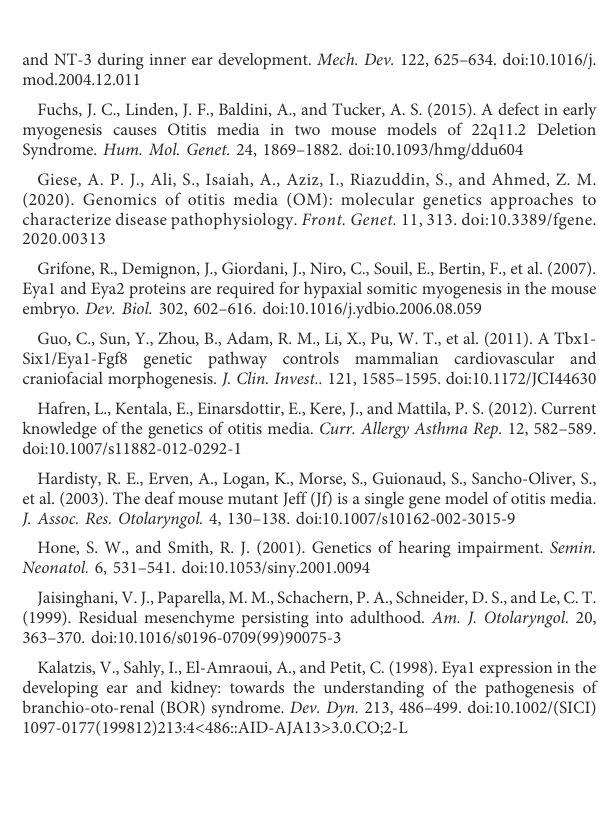
SUPPLEMENTARY FIGURE S2 No clear sex differences in cavitation or ET angle. Comparison of bulla volume ( (A) , left hand ears), bulla bubble size ( (B) , all ears) and ET angle ( (C) , all ears) in female and male mice from the same litter. SUPPLEMENTARY FIGURE S3 Eya1 is expressed in the inner ear at P11. RNAscope multiplex fl uorescence assay for Ecad in red ( ‘ ) and Eya1 ( ‘’ ) in green. Inner ear. (B,C) higher magni fi cation of boxes in (A) . Eya1 was expressed in the hair cells in the organ of corti. N =2, Scale Bars: (A) = 200 µm; (B,C) = 50 µm. SUPPLEMENTARY FIGURE S4 Increased proliferation of the middle ear epithelium during otitis media. Immuno fl uorescence for PCNA (red) at p21 in WT and Eya1 heterozygous (D – I) middle ears with (D – F) and without (G – I) Otitis media (OM). (A – C) Control littermate with no proliferation evident in the epithelium of the middle ear. (D – F) The epithelium is proliferative (red) (arrows note proliferating epithelial cells) in cases of OM all across the middle ear, including the hypotympanum (D) , Promontory (E) and Attic (F) . (G – I) The contralateral ear of this mouse showed no evidence ofOM, andverylimitedproliferation incomparisonto theearwith otitis media (OM). Dotted line underlines the epithelium. N=2 Eya+/+; N=3 Eya1+/ − . Scale Bars=50 µm. SUPPLEMENTARY FIGURE S5 Rescue of OM after rederivation to a clean environment. When transferred to a clean colony, Eya1 heterozygotes are able to complete cavitationofthemiddleearsothattheyareindistinguishablefromwild- type littermates (A) . Arrows indicate areas of the attic that are completely free from mesenchyme. No mesenchyme in N = 21/22 Eya1 Het ears. All scale bars set to 200